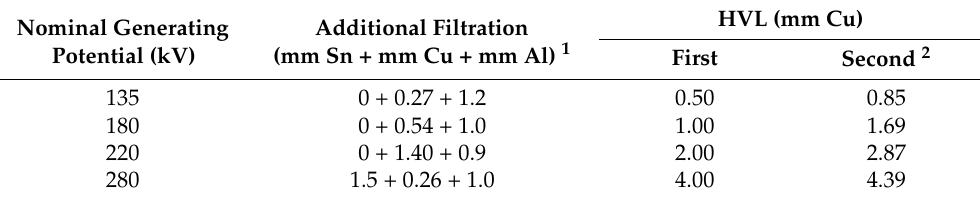
Table 1. NPL therapy level (medium-energy X-rays) reference qualities.